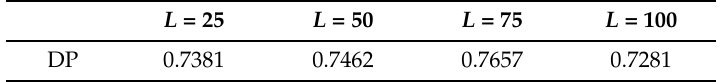
Table 7. Dataset-level precision (DP) under different numbers of nearest neighbor nodes.